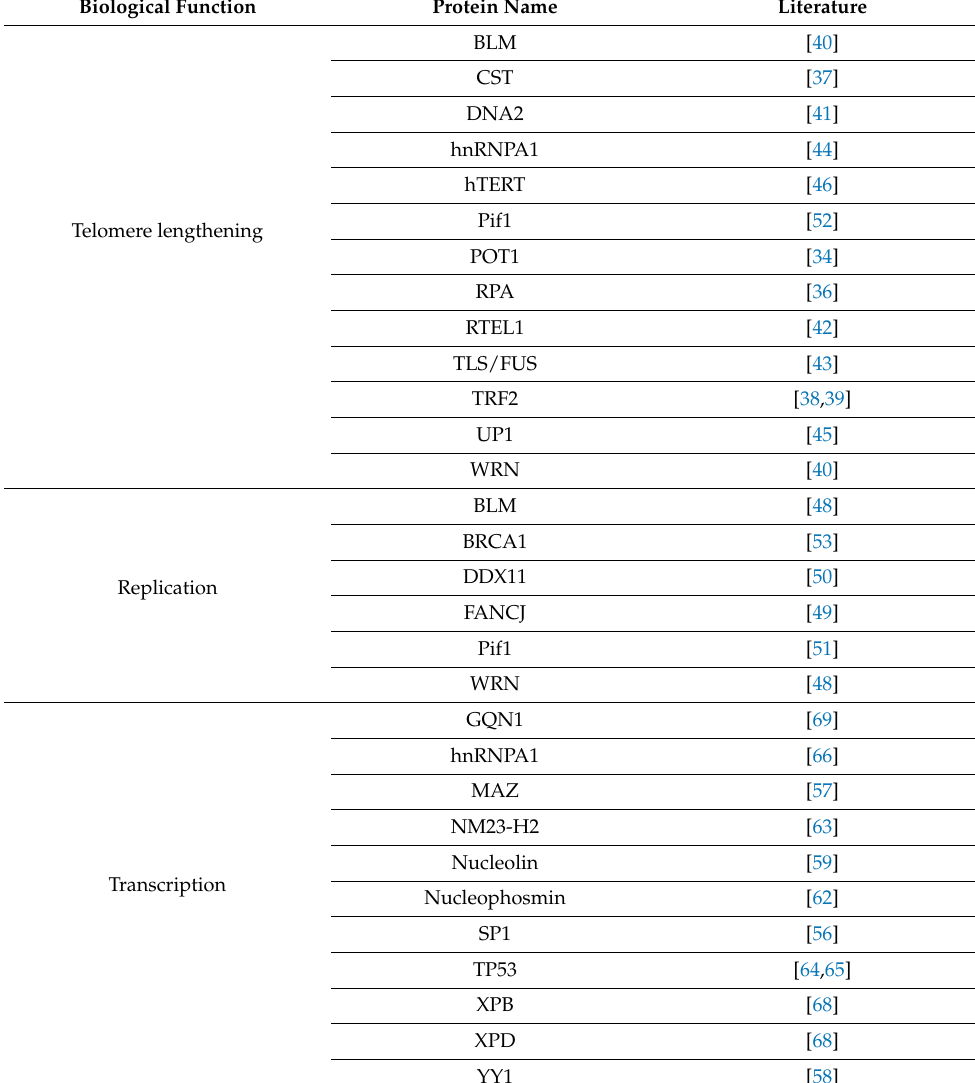
Table 1. G4BPs involved in telomere lengthening, replication, transcription, and chromatin remodel- ing and histone modification. List of all G4BPs (alphabetically sorted) grouped according to their biological function. Literature column shows the reference in which the protein was first described as a